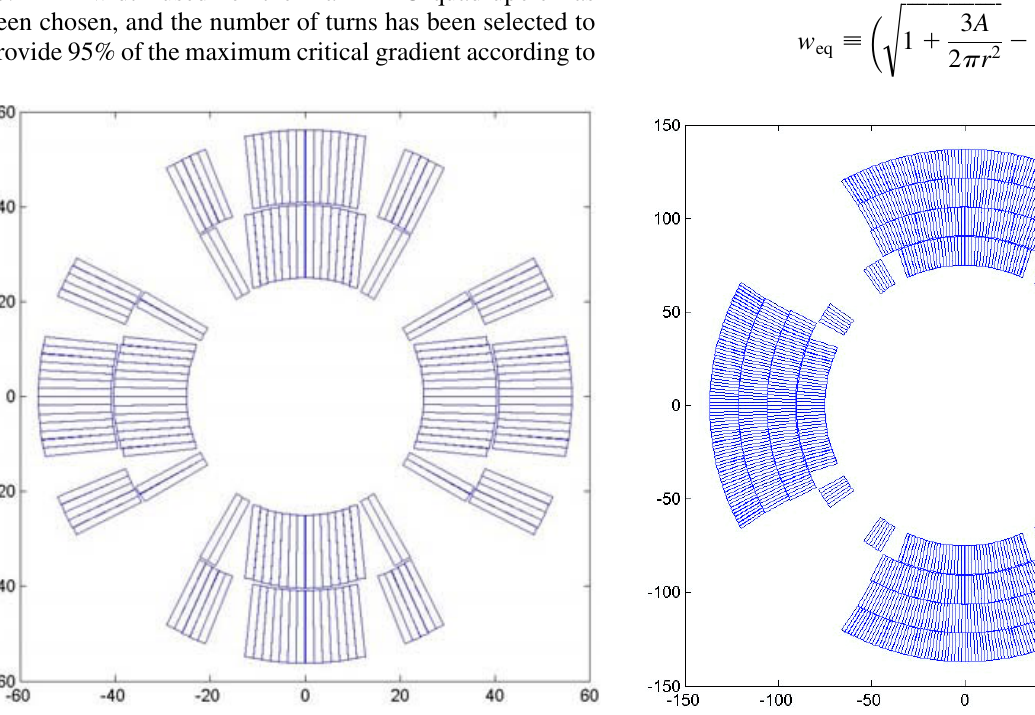
FIG. 7. (Color) Coil layout of a quadrupole with 150 mm aper-